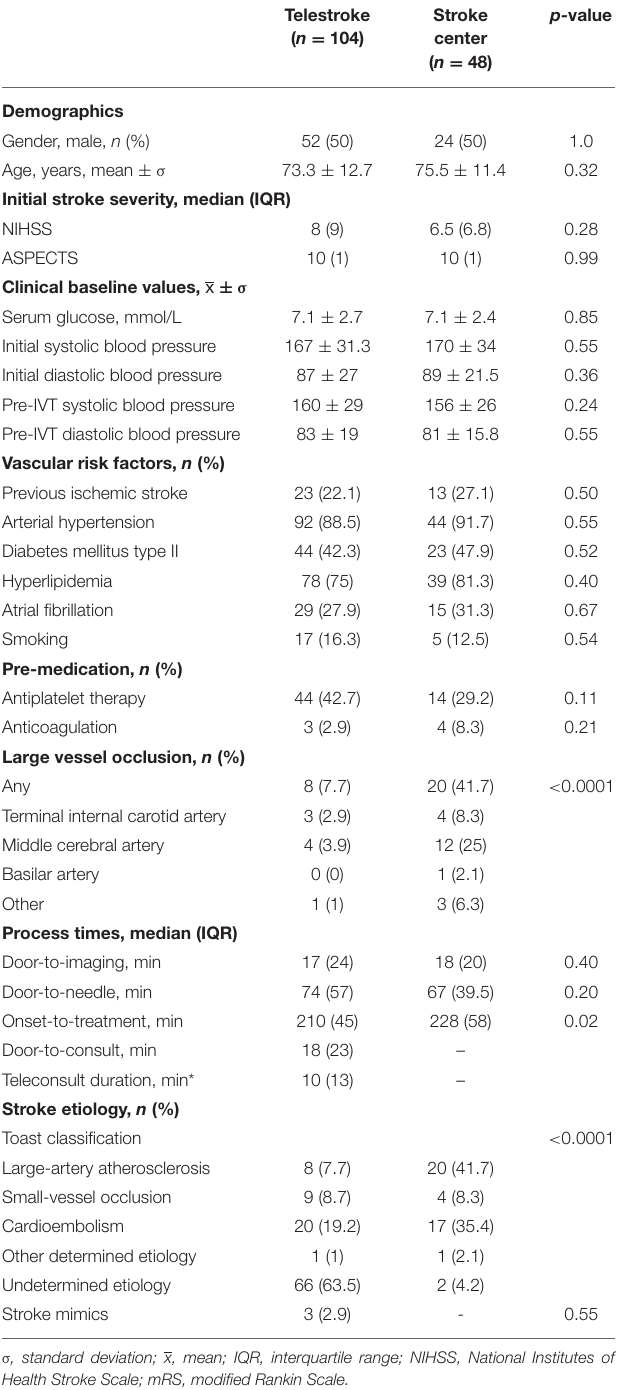
TABLE 1 | Clinical characteristics, process times, and stroke etiologies of the study population.